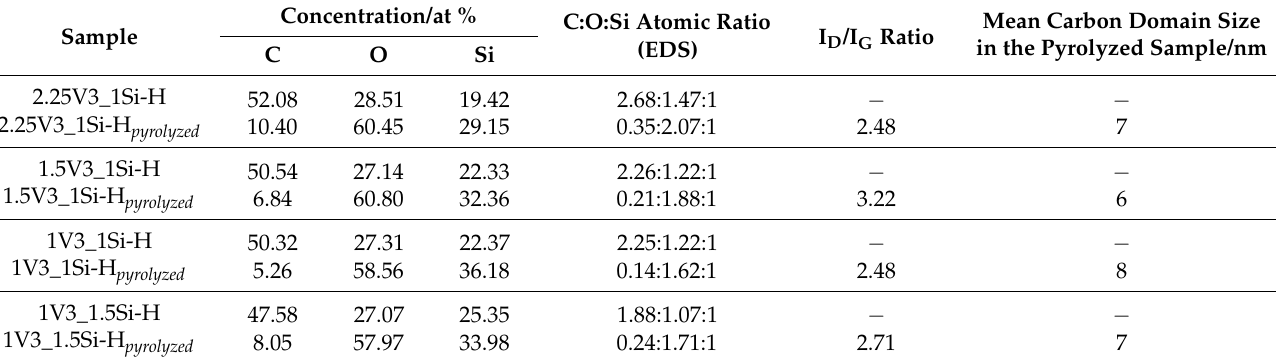
Table 2. EDS quantification of C, O, and Si concentrations in selected microareas, ratios of integral intensity of the D (I D ) and G (I G ) bands in the Raman spectra and mean carbon domain sizes in the pyrolyzed samples calculated based on Raman spectra of the pyrolyzed